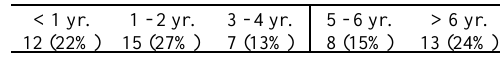
As seen in the table 5, about 50% of drug users came for consultation within 2 years of their drug use. This shows that drug addicts want help to get rid of their drug